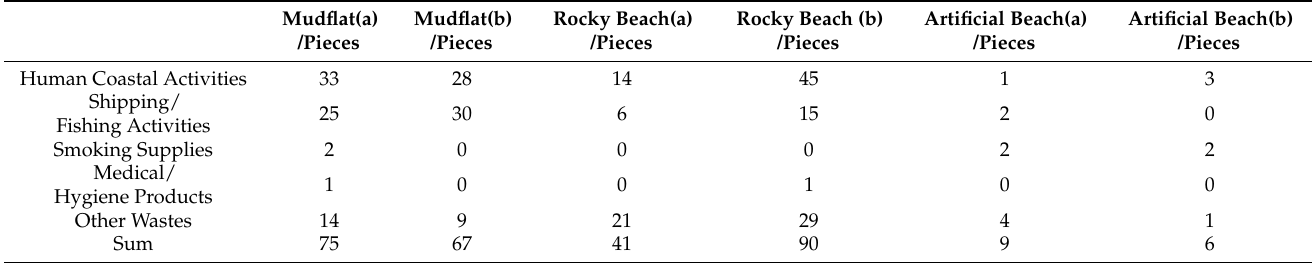
Table 4. Sources classification of marine litter from the survey